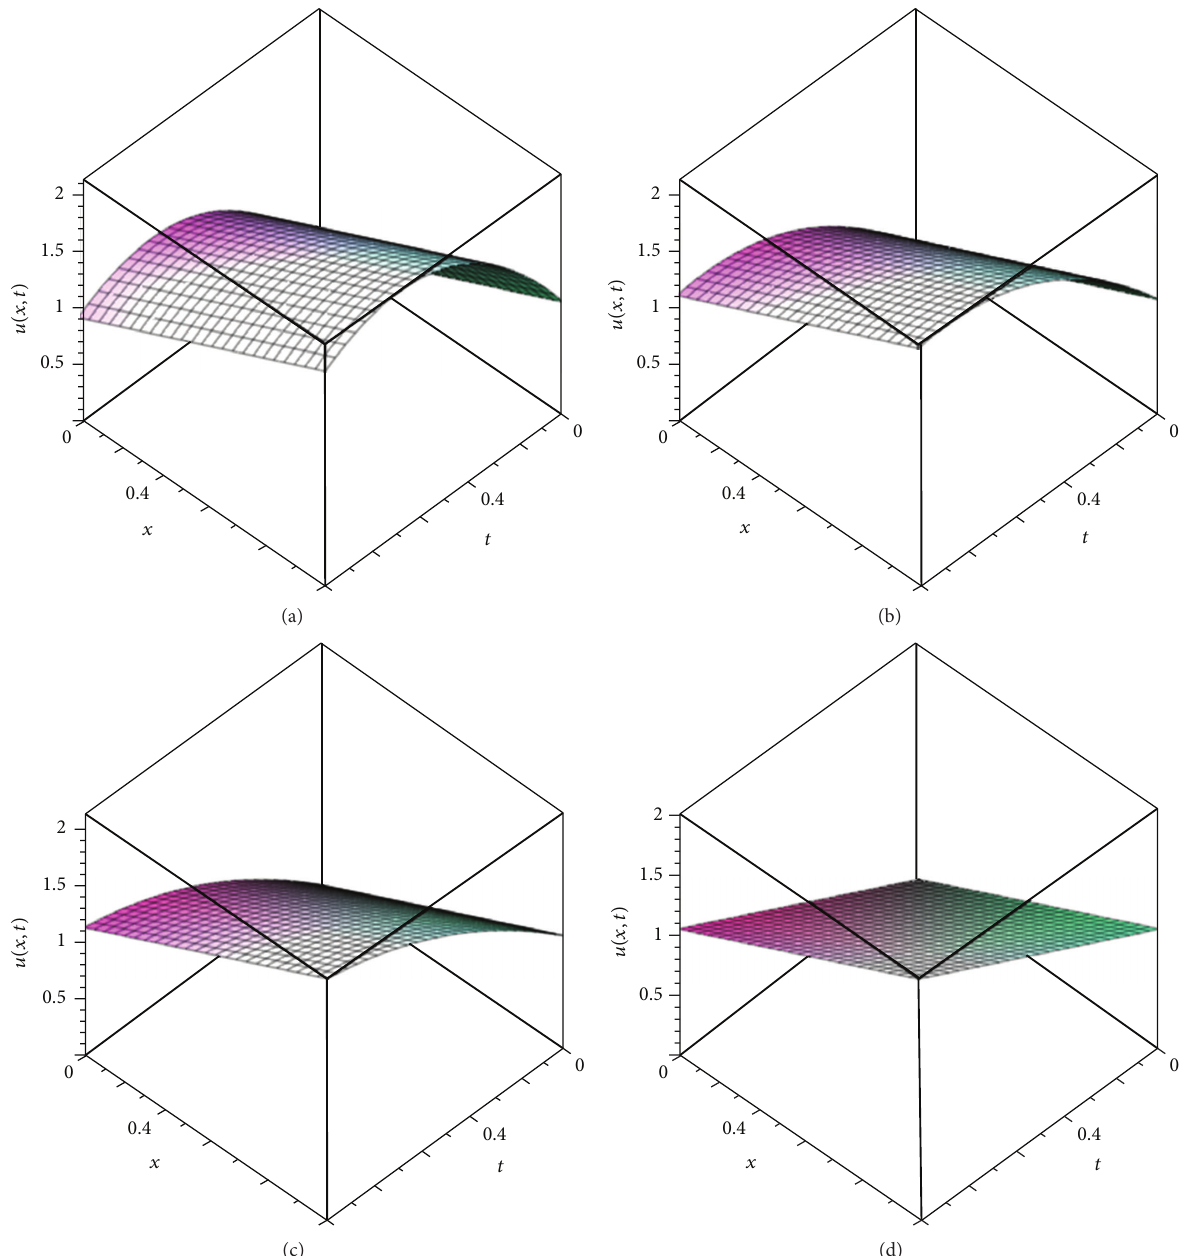
Figure 1: (a) Plot of 𝑢(𝑥,𝑡) with respect to 𝑥 and 𝑡 at 𝛼 = 1/3 . (b) Plot of 𝑢(𝑥,𝑡) with respect to 𝑥 and 𝑡 at 𝛼 = 1/2 . (c) Plot of 𝑢(𝑥,𝑡) with respect to 𝑥 and 𝑡 at 𝛼 = 2/3 . (d) Plot of 𝑢(𝑥,𝑡) with respect to 𝑥 and 𝑡 at 𝛼 = 1